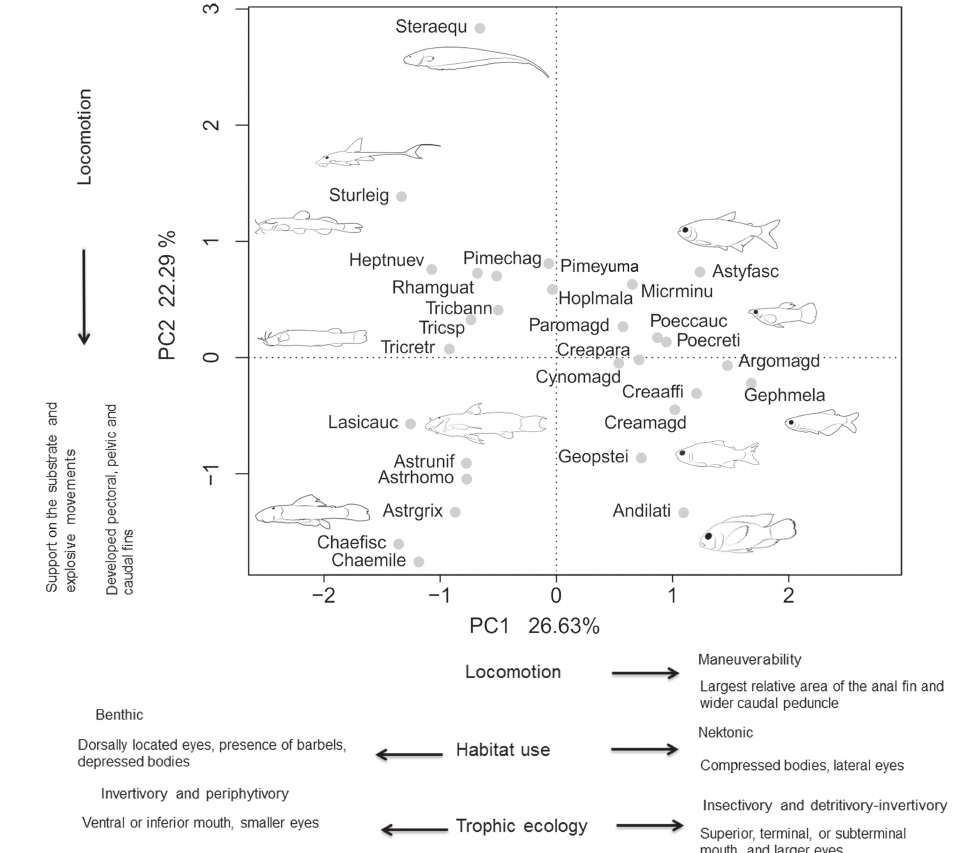
Fig. 3. Projection of the two principal components of 29 fish species in the trans-Andean basin of the Alvarado River, Upper Magdalena, Colombia. List of species abbreviations in Tab.